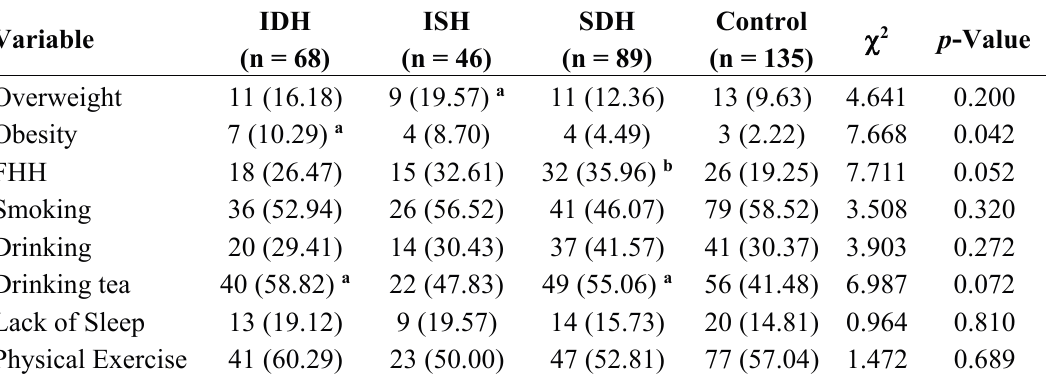
Table 3. Comparison of physical and behavioral of each group.